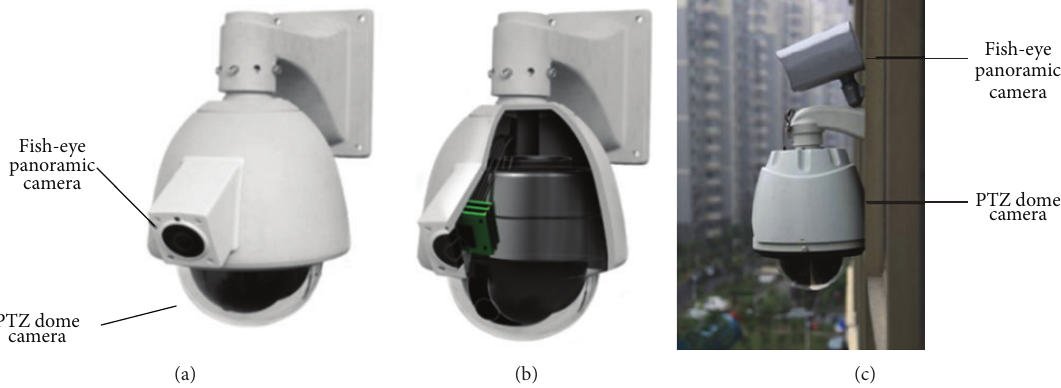
Figure 2: (a) The master-slave visual surveillance system. (b) The internal structure of the proposed system. (c) Most existing surveillance systems can be upgraded to the master-slave system by adding a fish-eye camera above the traditional PTZ camera, or adding a PTZ dome camera underneath the panoramic